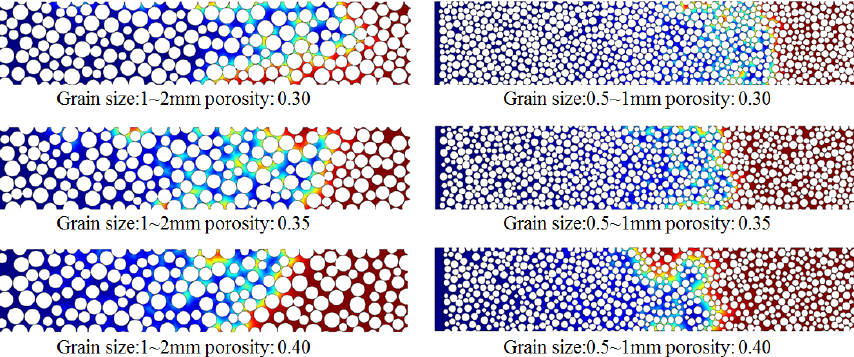
Figure 5. Distribution of grout suspension at the time of 2 sec with different grain size and poros- ity.